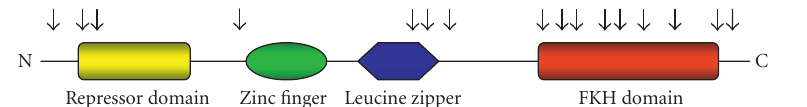
Figure 1: Schematic representation of human FOXP3. Arrows indicate the location of identified missense point mutations in patients with